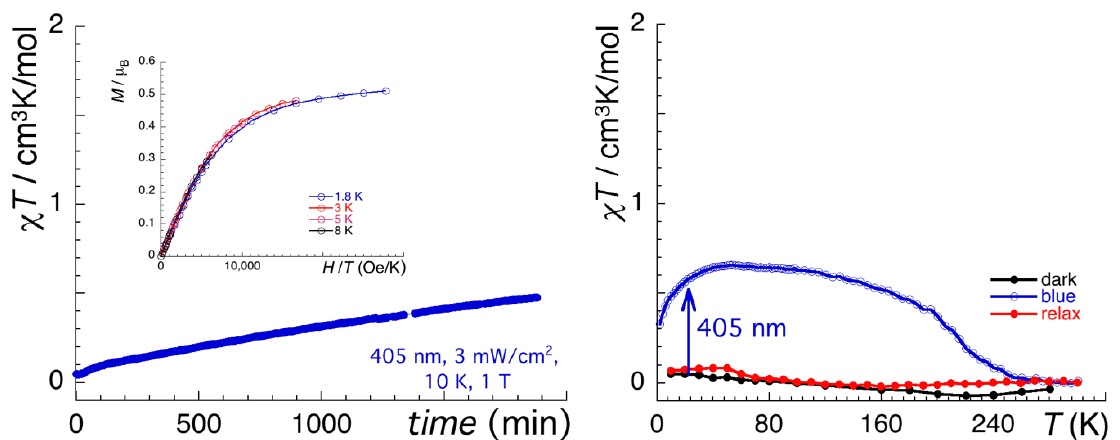
Figure 5. ( Left ) Time dependence of the χ T product measured at 1 T during 405 nm light irradiation (0.3 mW/cm 2 ) (Inset: Reduced magnetizations at different temperatures (1.8 K, 3 K, 5 K and 8 K) in the photo-excited state of 3 ). ( Right ) χ T = f( T ) plots at 1 T and 0.4 K/min of 3 measured in the dark before any light irradiation, after 405 nm irradiation and after reconditioning to 300 K.